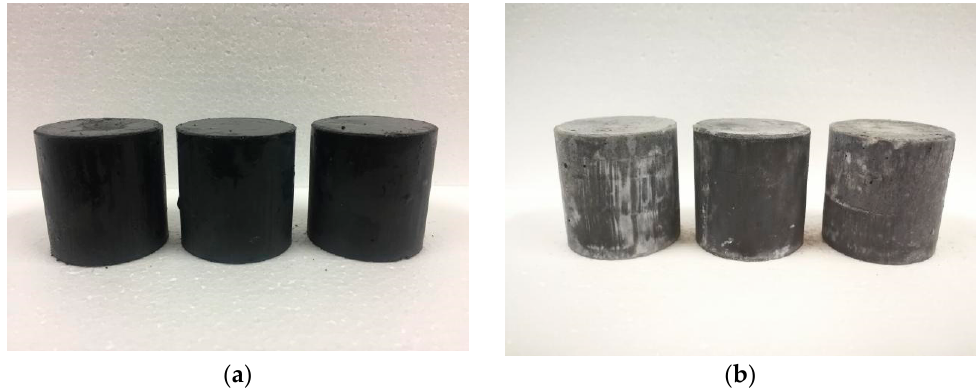
Figure 12. M–S–H cement-solidified body with 0.8 wt % Cs + before ( a ) and after ( b ) freeze–thaw testing.